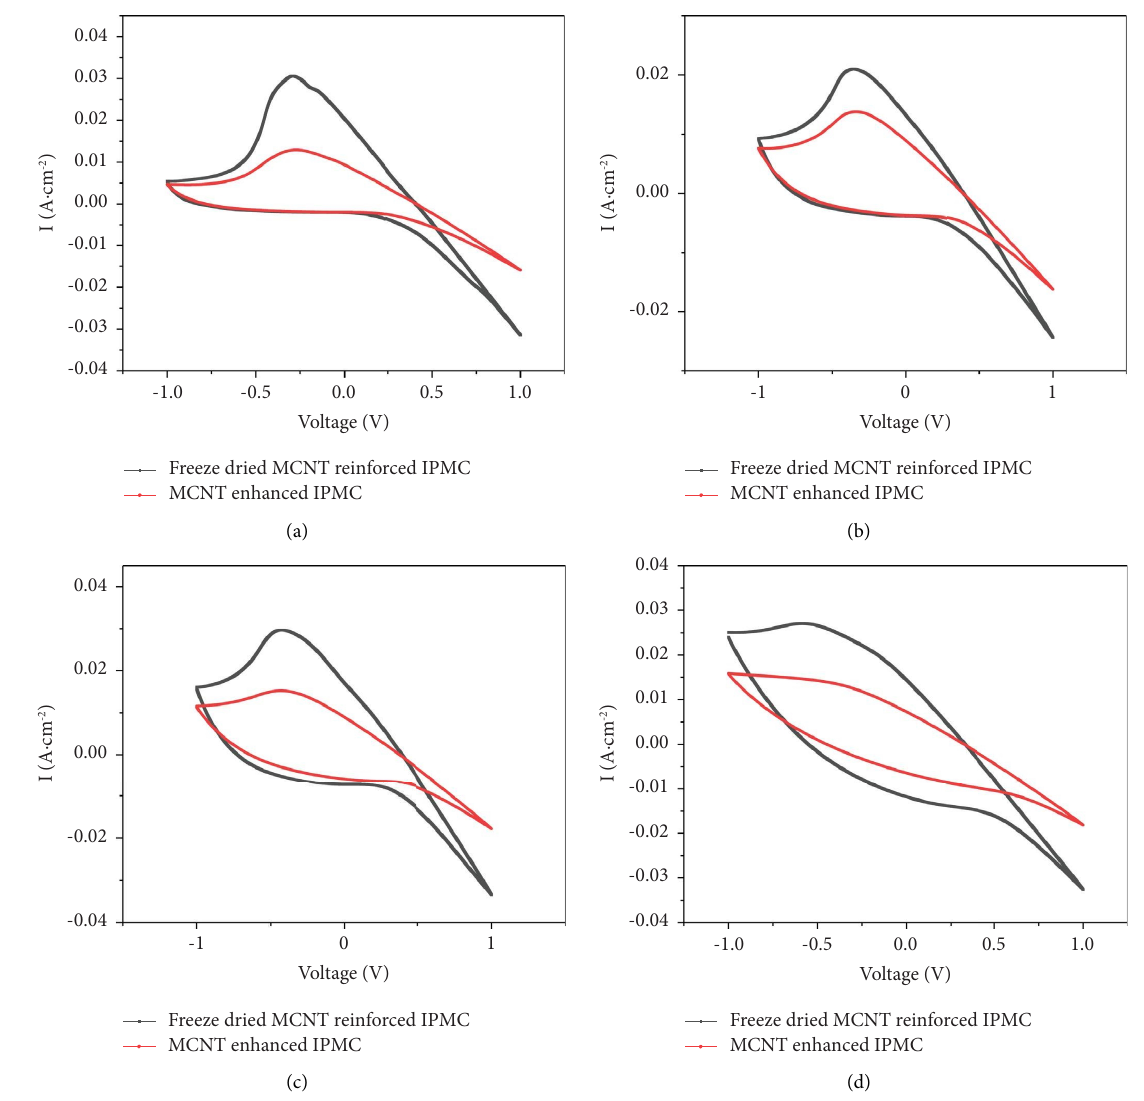
Figure 5: CV diagram of IPMC containing carbon nanotubes with a scanning interval of − 1V–1 V: (a) 50mV/s; (b) 100mV/s; (c) 200mV/s; (d)